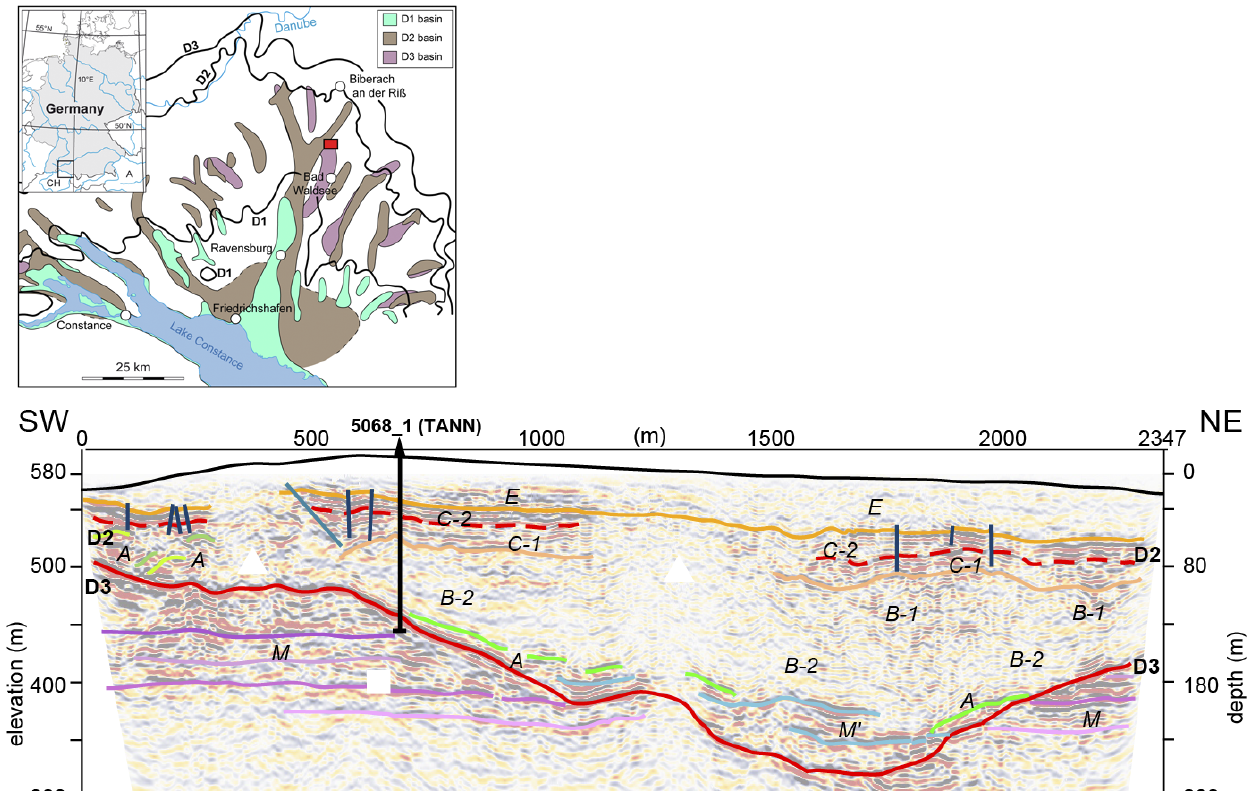
Figure 7. Top: maps displaying the location of the DOVE Phase 1 site 5068_1 (TANN) with relation to different generations of overdeepened basins (after Ellwanger et al., 2011). Bottom: interpreted seismic section and superimposed interpretation of profile 1 across the Tannwald basin (from Burschil et al., 2018). Elevation (black line) and faults with offsets > 2m (dark blue). D3 (base of basin) and D2 are regional dis- continuities that separate major sedimentological units. Seismic facies: M upper freshwater molasse, M’ allochthonous molasse, A lodgement till, B basin fines, C till sequence, and E fluvial